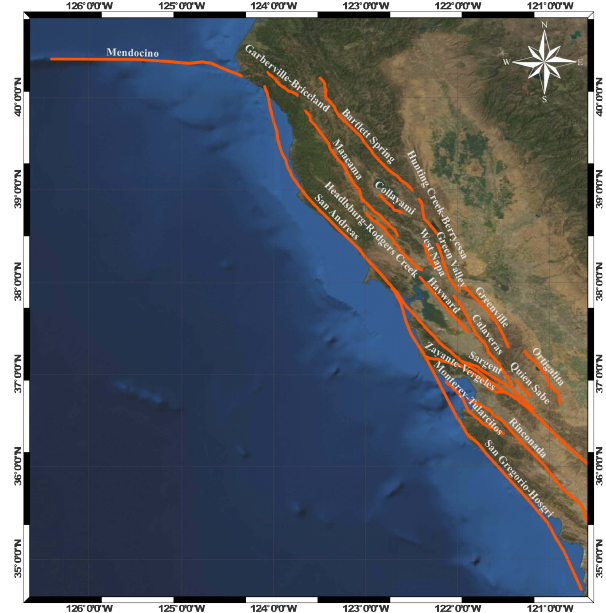
Fig. 1. Map of the strike-slip faults considered in our VC simulation of northern California seismicity. These are the major strike-slip faults that make up the San Andreas plate-boundary deformation in northern